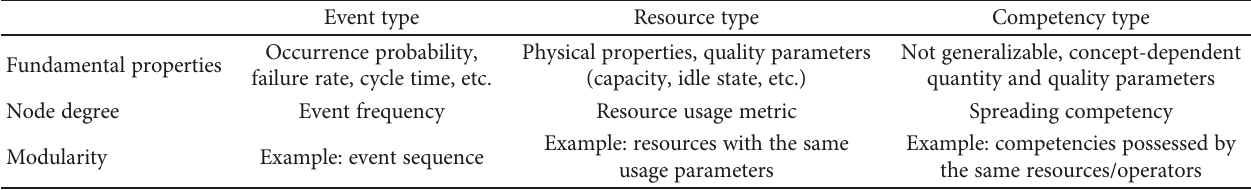
Table 3: Node types of the proposed network.